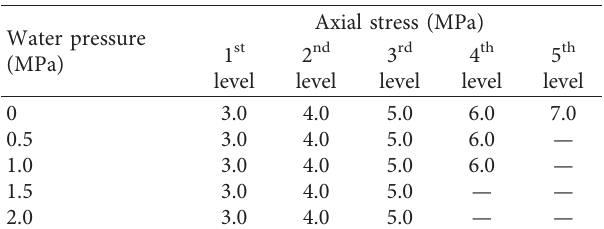
Figure 11: Creep loading method. Table 2: Creep loading